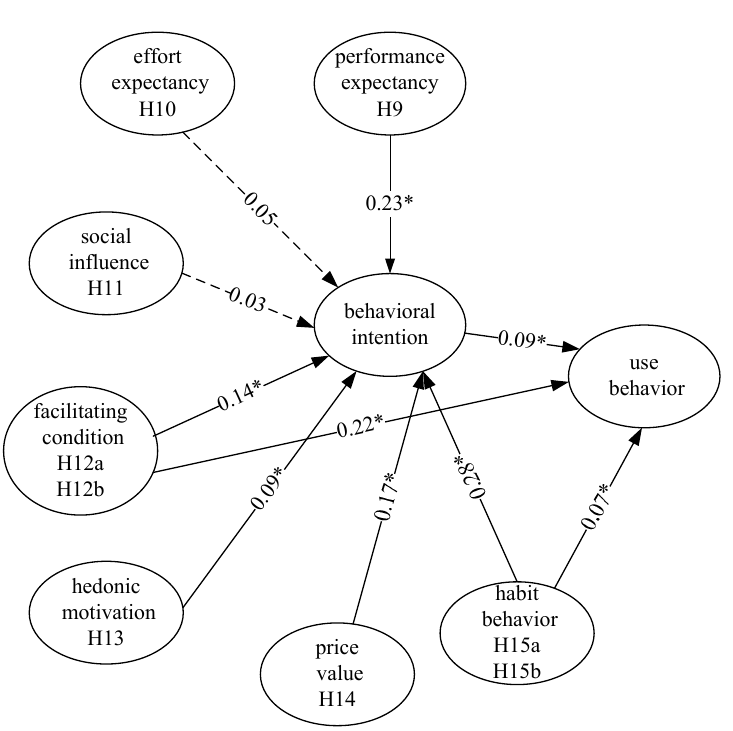
Figure 6. Seven independent variables and behavioral intention effect on use behavior. * p < 0.05.